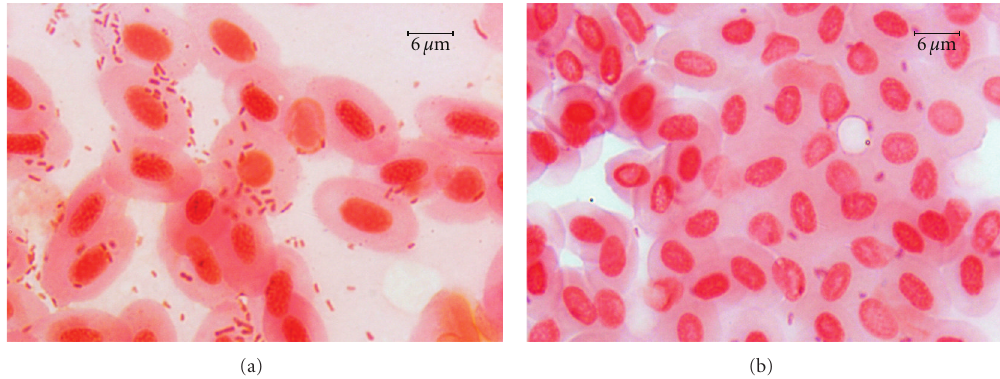
Figure 8: Numerous bacterial cells of A. hydrophila strain Pt 104 (a) and isolated cells of A. veronii bt. sobria strain W62 (b) adhering to trout blood